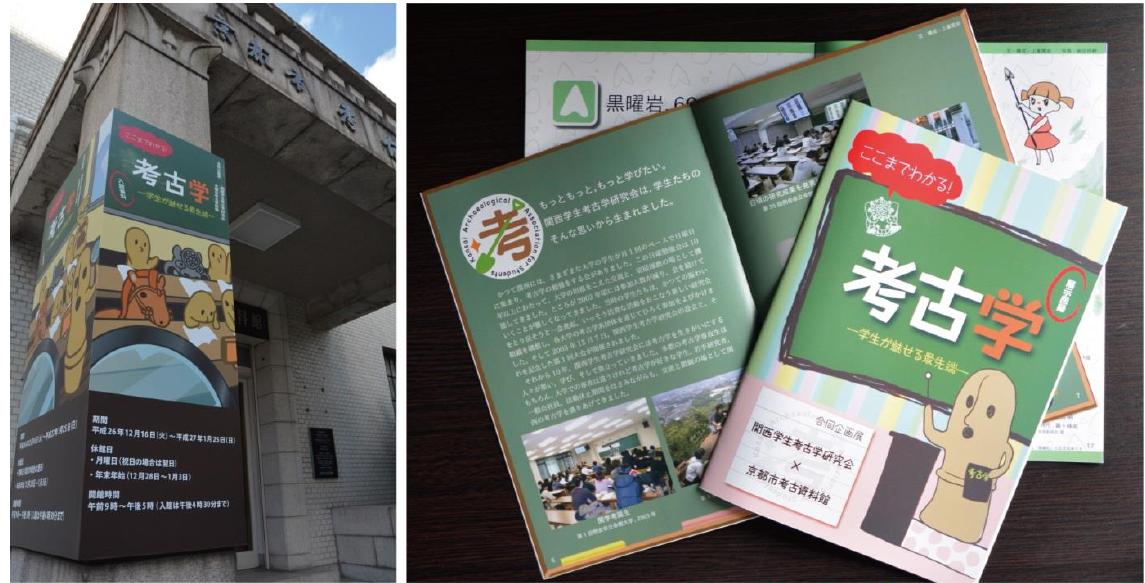
Figure 2. Signboard and pictorial record book designed by the students of Osaka-Seikei University.